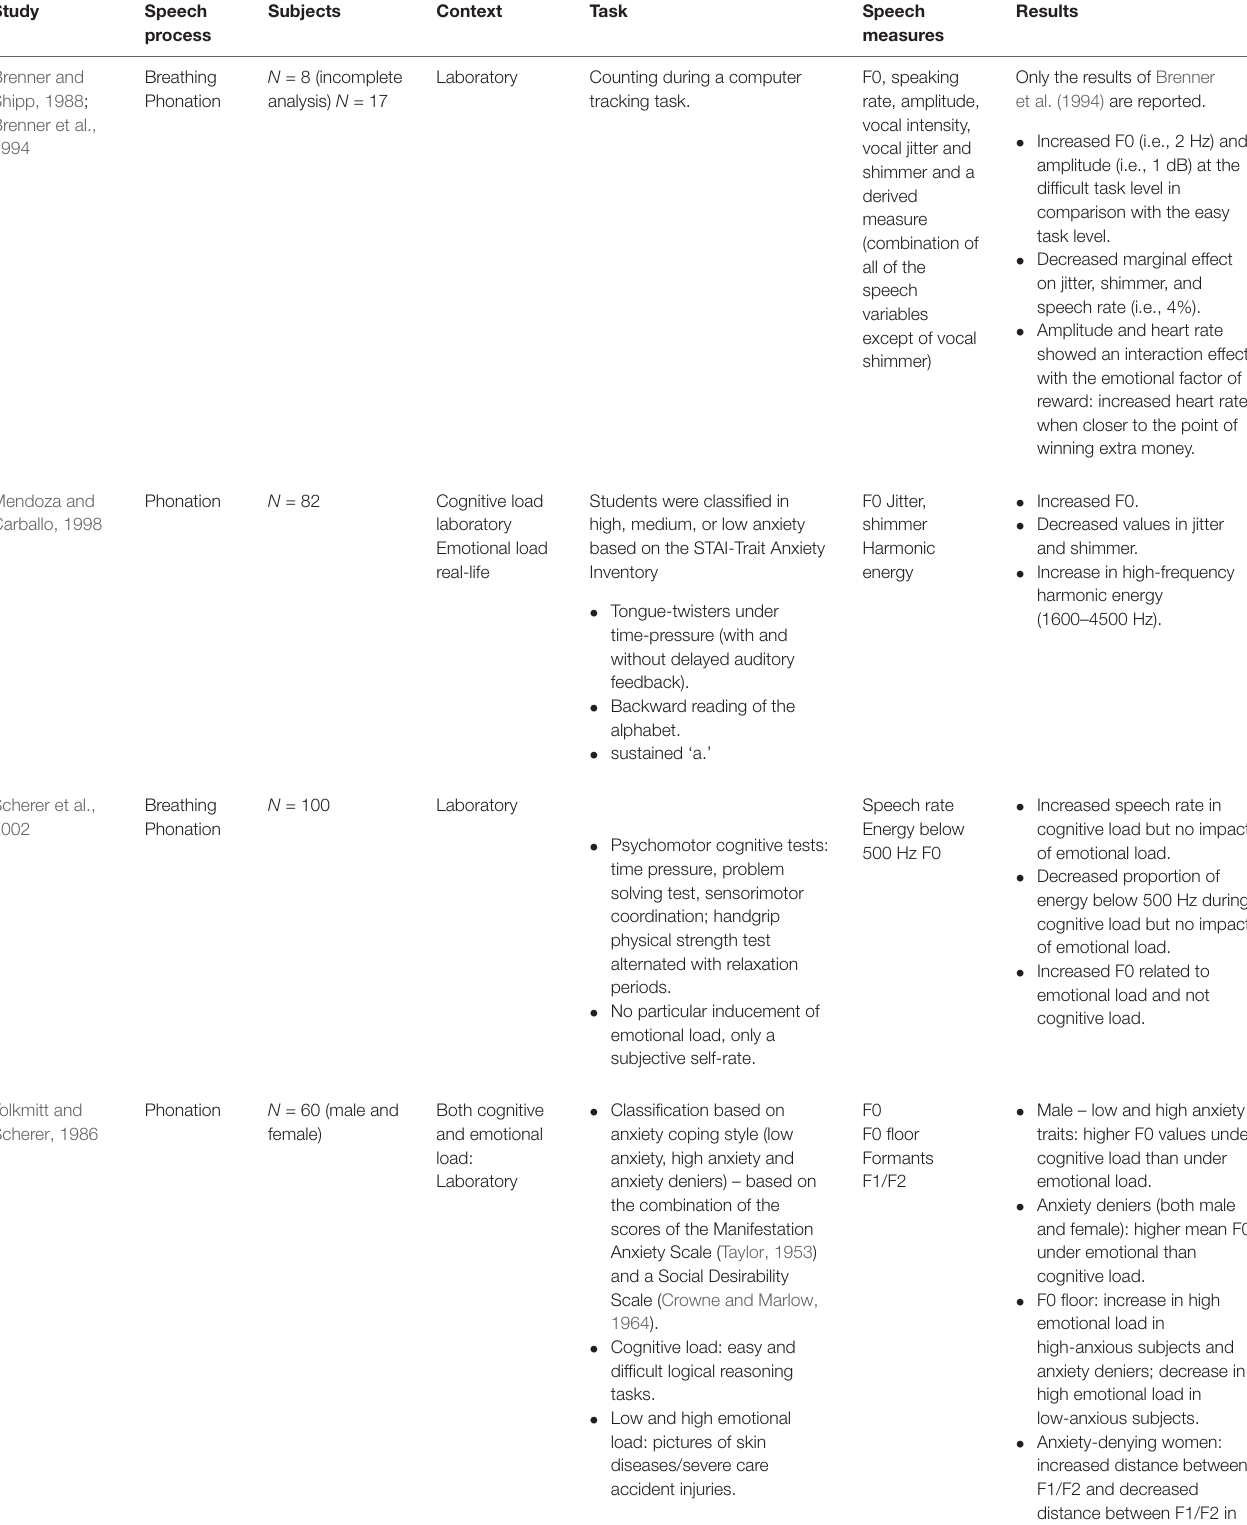
TABLE 7 | Studies on the impact of mixed cognitive and emotional load on voice and speech